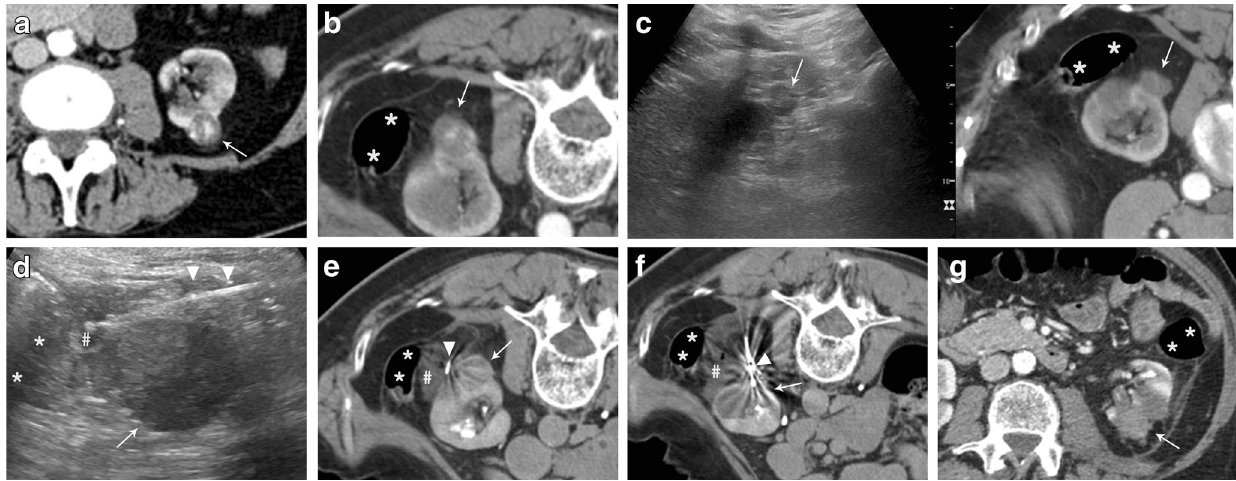
( arrowheads ) is placed in between the tumour ( white arrow ) and colon ( asterisks ) and fluid ( hash ) is injected. e A CTscan performed after fluid ( hash ) injection confirmed the correct displacement of the colon ( asterisks ) from the target tumour ( white arrow ) ( arrowhead = spinal needle ). f CTscan demonstrating the insertion of the microwave antenna ( arrowhead ) into the renal tumour ( white arrow ) ( asterisks = colon; hash = injected fluid ). g Contrast-enhanced CT performed the day after treatment demonstrating the complete ablation of the renal tumour ( white arrow )without complications ( asterisks = colon